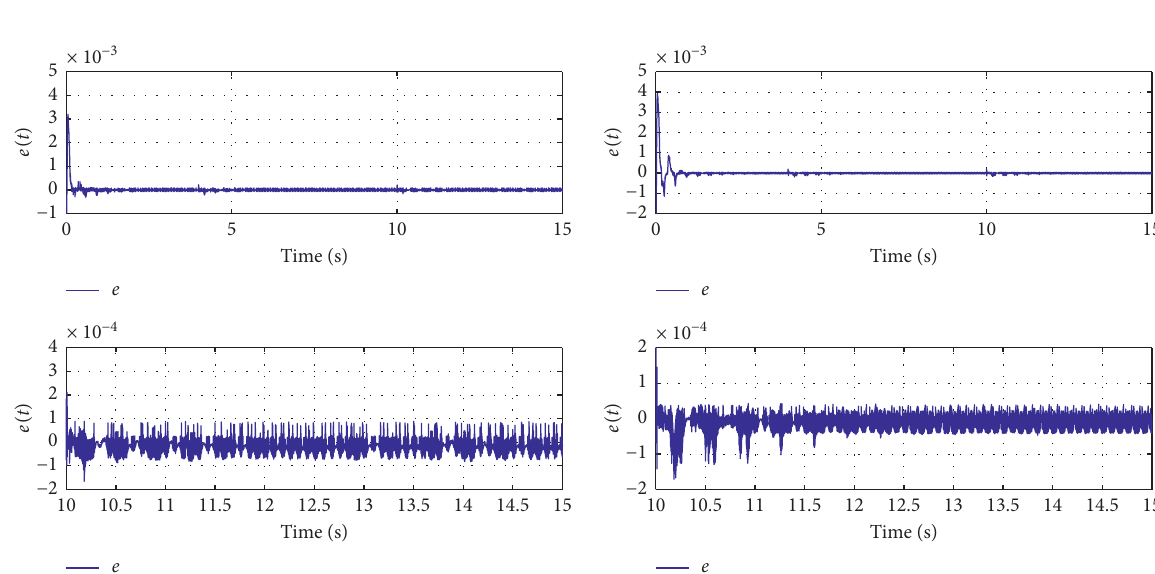
Figure 11: Control performance of IOSM and NN-FFOSM in case